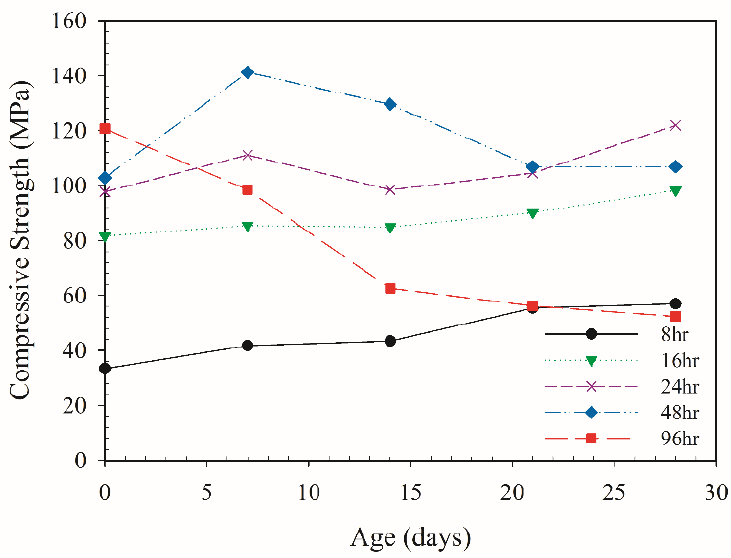
Figure 11. Changes in compressive strength with standing time in air under various curing durations of specimens cured at 70 °C when AE% = 3%.